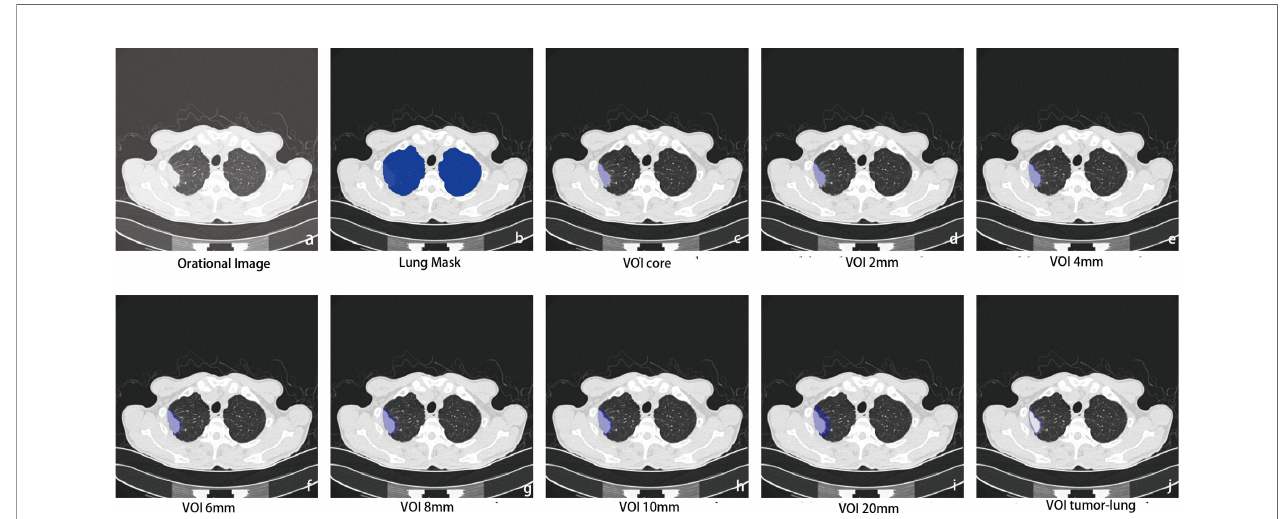
FIGURE 2 | Intra- and perinodular segmentation. Erosion and expansion algorithm programs were used to capture the perinodular area, and then the intranodular mask was subtracted from the expanded mask to obtain perinodular areas from the tumor surface. (A) Plan CT image shows subpleural solid nodules in the upper lobe of the right lung; (B) lung tissue segmentation mask: perinodular area was dilated within this area to remove the extrapulmonary structures; (C) manual labeling to obtain the original 3D region of interest as the core area (VOI core ), which was used as a seed to expand outward within the lung tissue mask. (D – I) The different distances of 3D regions of interest from the tumor surface were obtained at 2, 4, 6, 8, 10, and 20 mm (marked as VOI 2 – 20 mm ); (J) the marginal regions of each 3 mm inside and outside the contour of VOI core were annotated (VOI tumor – lung